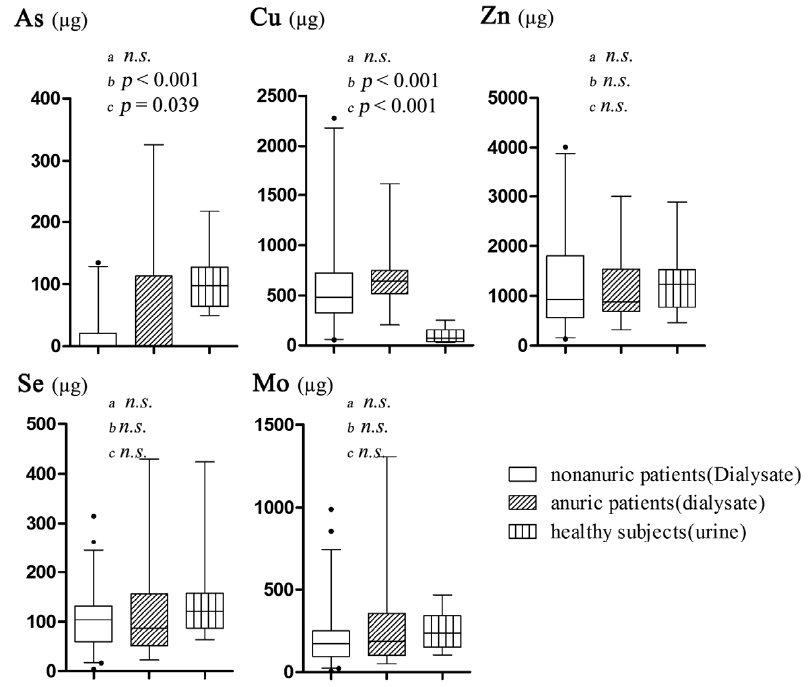
Figure 2. Comparisons of Cu, Zn, Se, Mo, and As excretions per day among dialysate of nonanuric patients and anuric patients and urine of healthy subjects. a nonanuric patients vs. anuric patients; b nonanuric patients vs. healthy subjects; c anuric patients vs. healthy subjects.